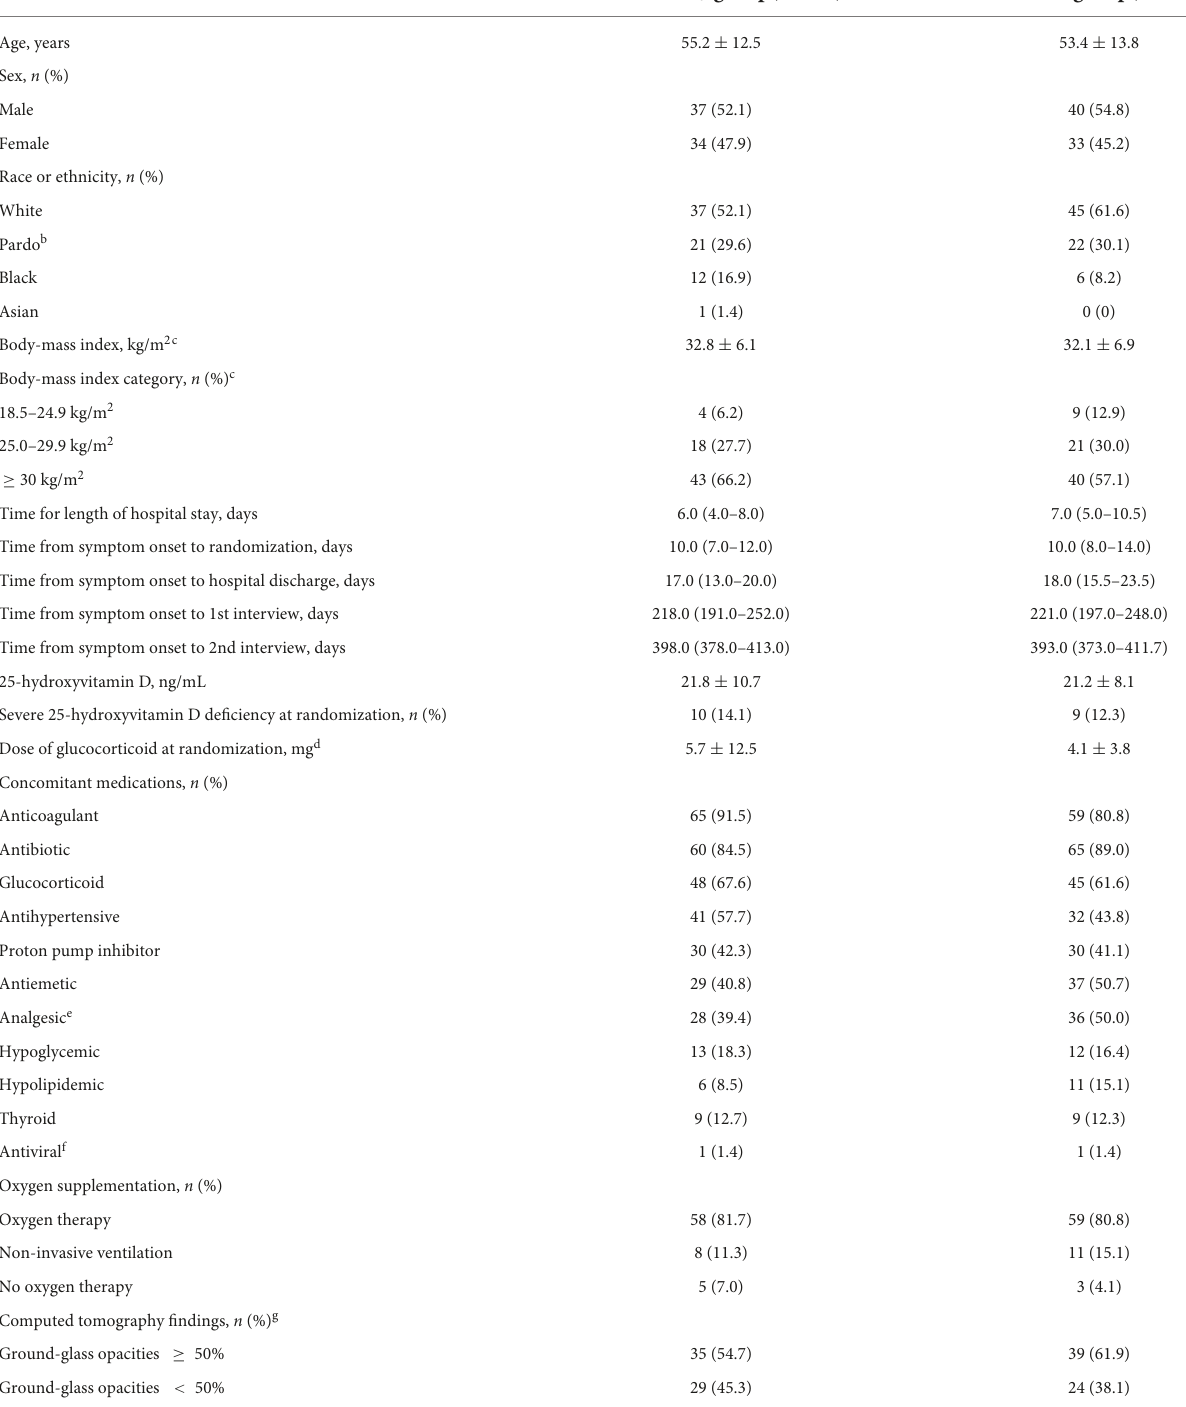
TABLE 1 Baseline demographic and clinical characteristics a